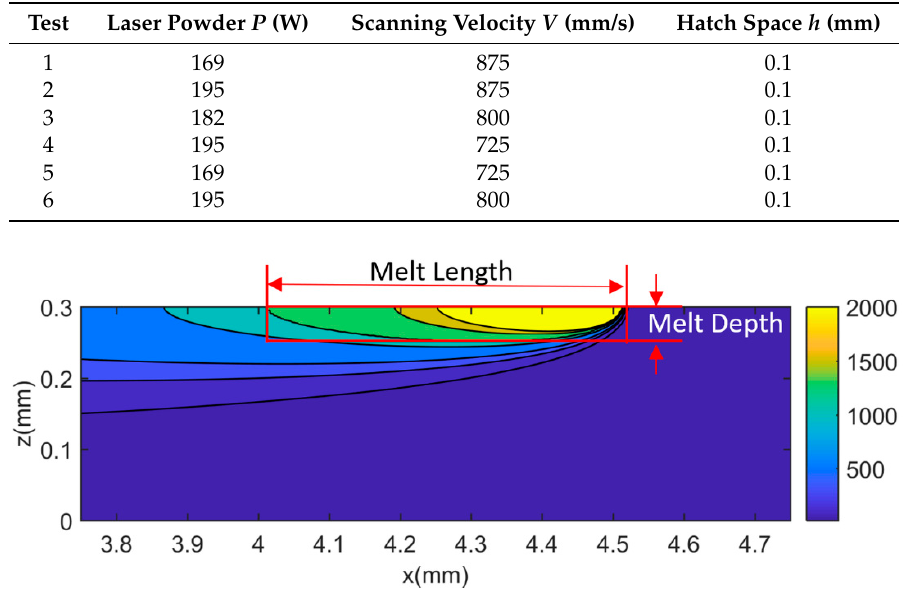
Table 1. Process conditions for single-track scans and bidirectional scans in SLM of Inconel 625 [18]. The layer thickness is 20 μ m.